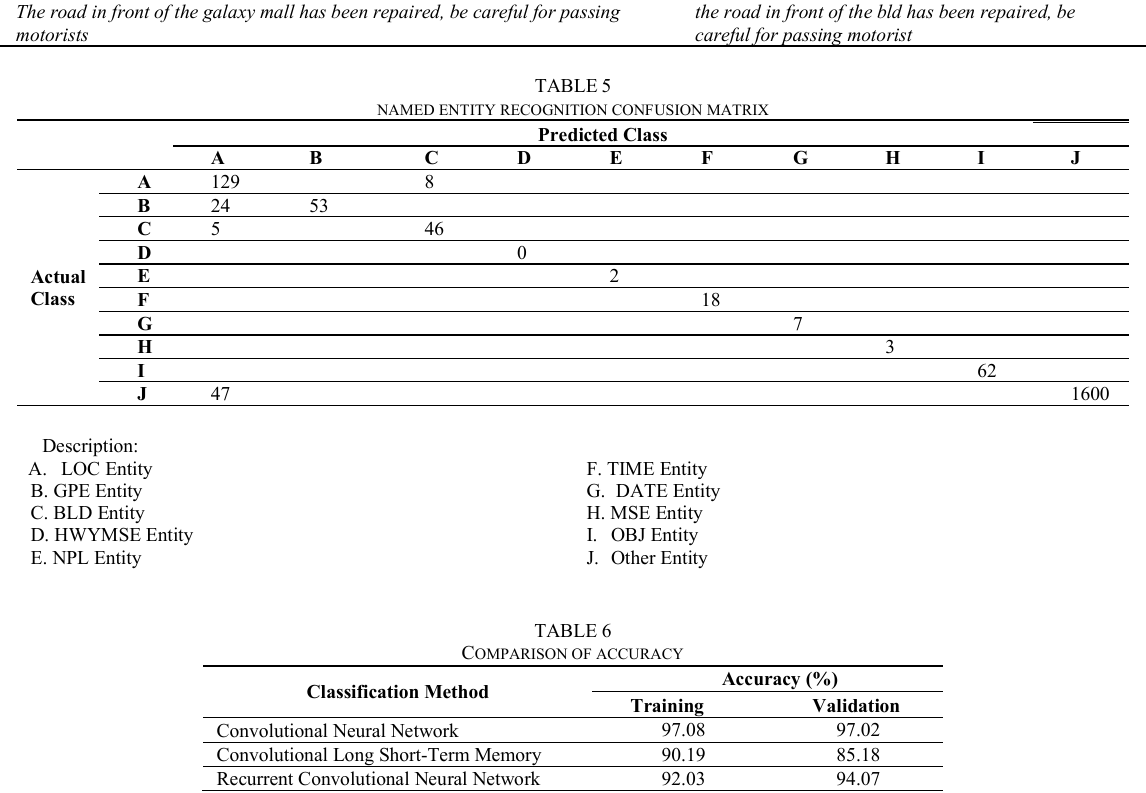
TABLE 5 NAMED ENTITY RECOGNITION CONFUSION MATRIX